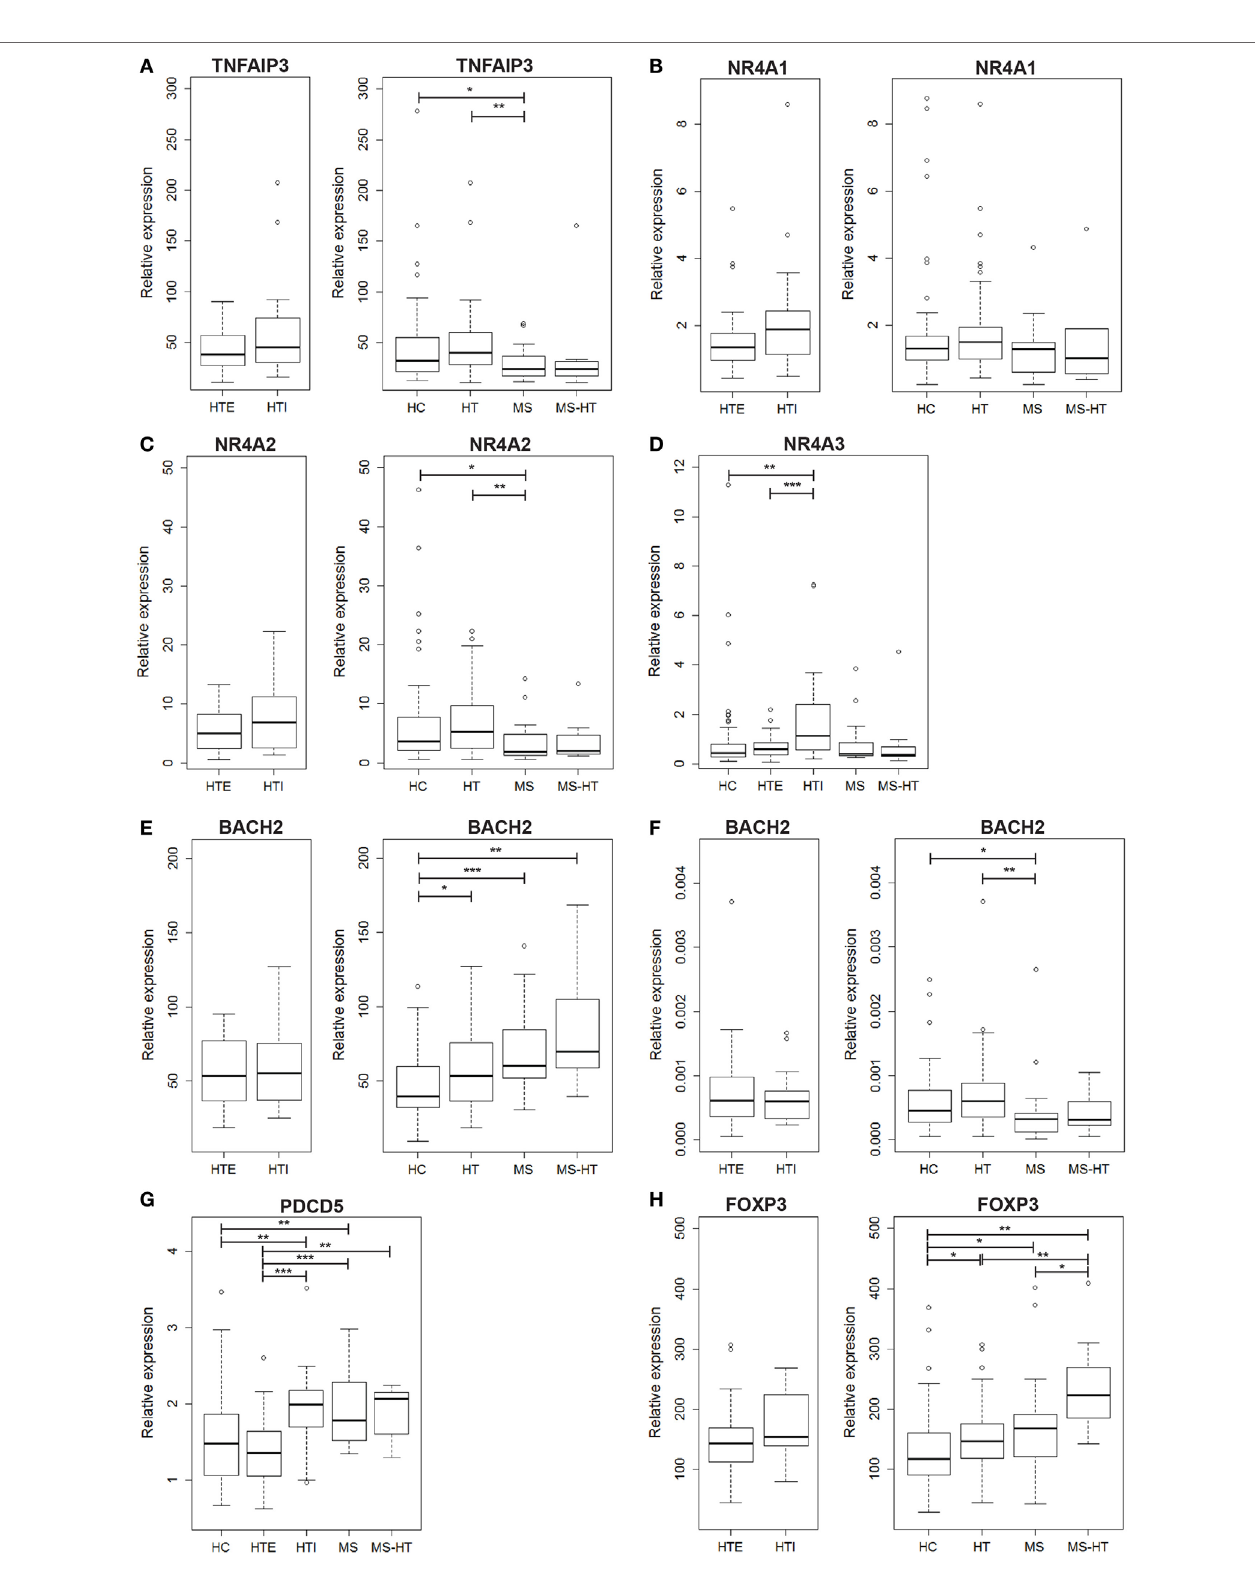
FigUre 1 | Peripheral blood mononuclear cell (PBMC) gene-expression levels of (a) TNFAIP3, (B) NR4A1, (c) NR4A2, (D) NR4A3, (e) BACH2, (g) PDCD5, and (h) FOXP3, and (F) whole peripheral blood gene-expression level of BACH2. Relative expression was calculated by the normalized comparative cycle threshold method (2 −ΔΔ Ct ) and differences between groups were evaluated by the Mann–Whitney U